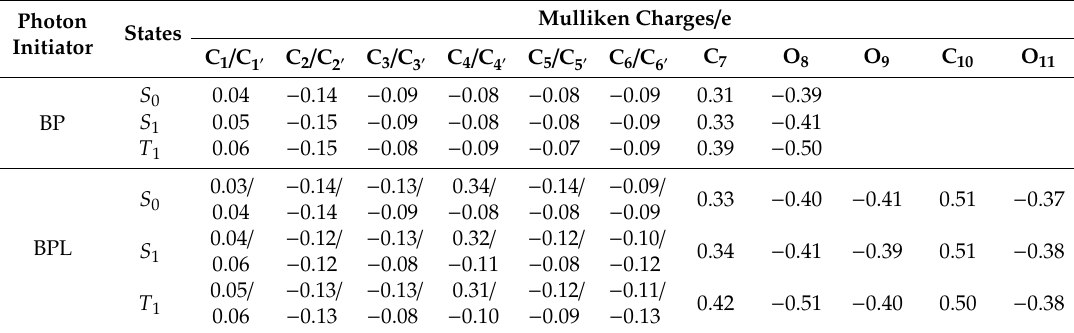
Figure 2. The electronic excited states and transitions of benzophenone (BP) and BPL. Table 2. Mulliken atomic charges of BP and BPL.